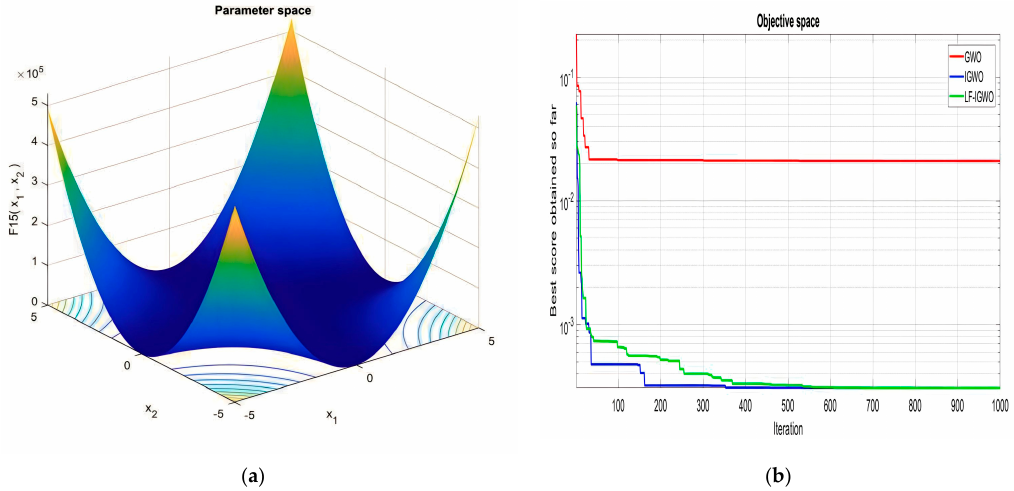
Figure 17. ( a ) Search space for fixed dimensional function F15 ( b ) Comparison of convergence curve for F15.